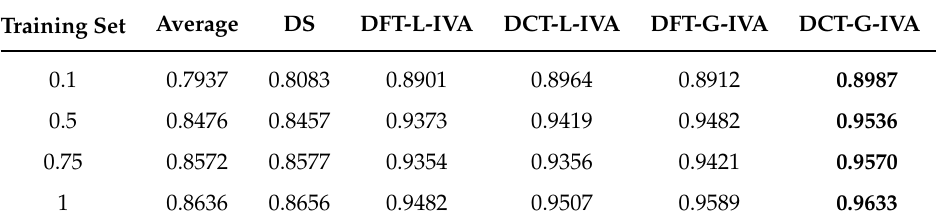
Table 4. Classification accuracies of moving targets in the wild. DS, delay-and-sum beamformer.